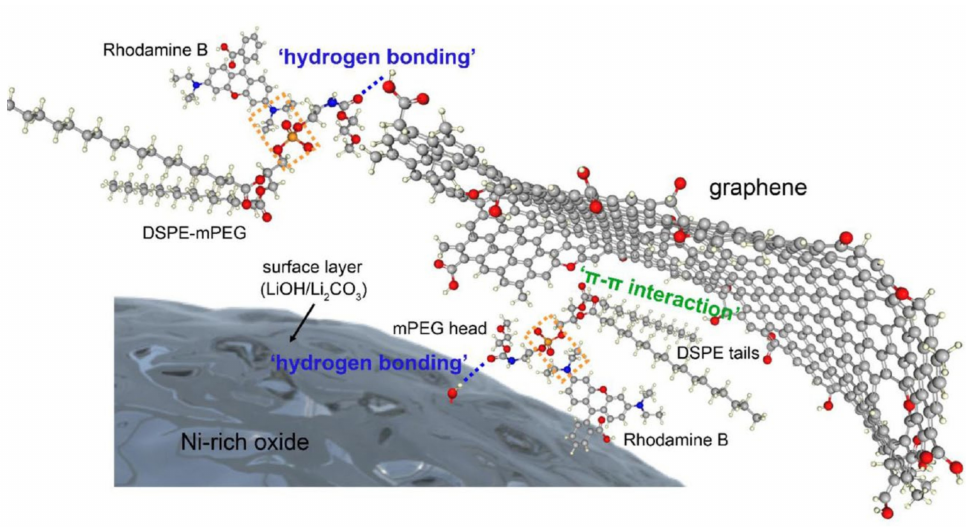
Figure 11. Schematic drawing of the bonding configuration between graphene and Ni-rich lithium metal oxide, where red, gray, ivory, blue, and orange colors represent oxygen, carbon, hydrogen, nitrogen, and phosphorus, correspondingly. Reproduced with permission from ref. [135]. Copyright 2021, Nature Publishing